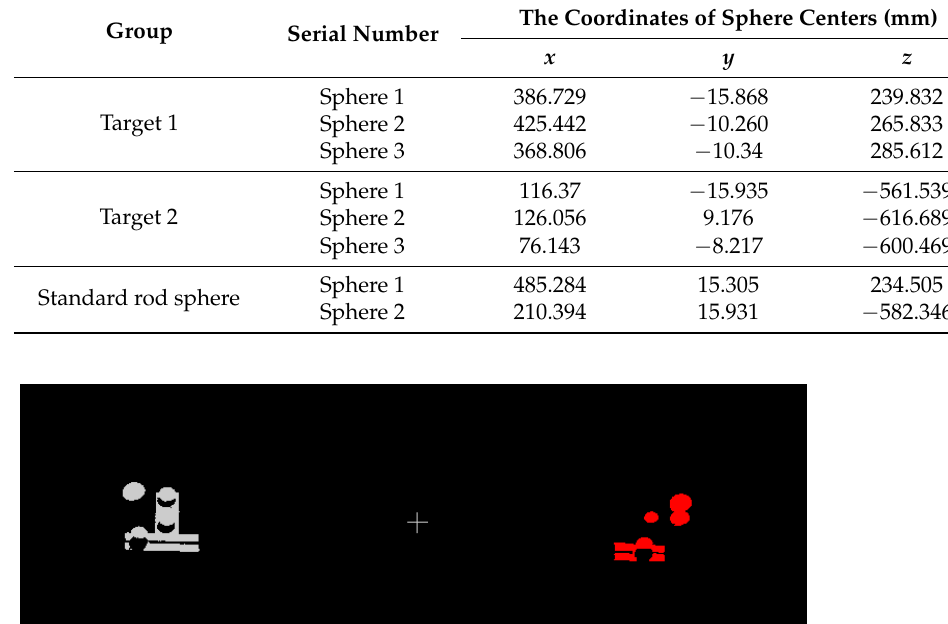
Table 7. Measurement data after coordinate unification.